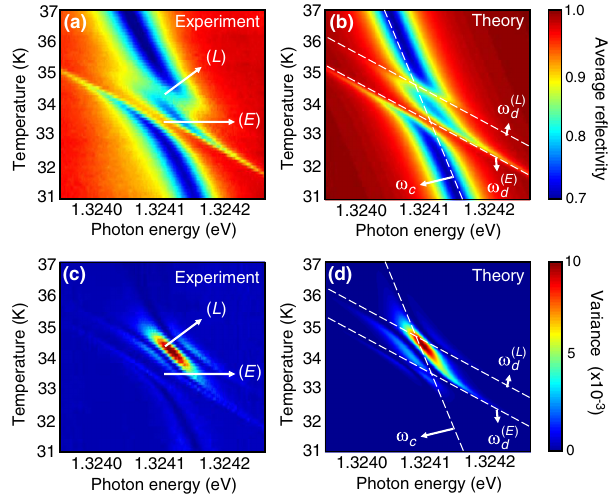
FIG. 4. (a) Experimental average reflectivity versus temper- ature and photon energy. (b) Simulated average reflectivity. (c) Experimental reflectivity variance versus temperature and photon energy. (d) Simulated reflectivity variance. The dashed lines in the simulated maps indicate the bare cavity mode and QD transition energies. The arrows in the experimental maps indicate ð L Þ ¼ ω where the anticrossings occur, which is when ω ¼ ω c (for d ð E Þ ¼ ω E state L ) or when ω ¼ ω c (for state d